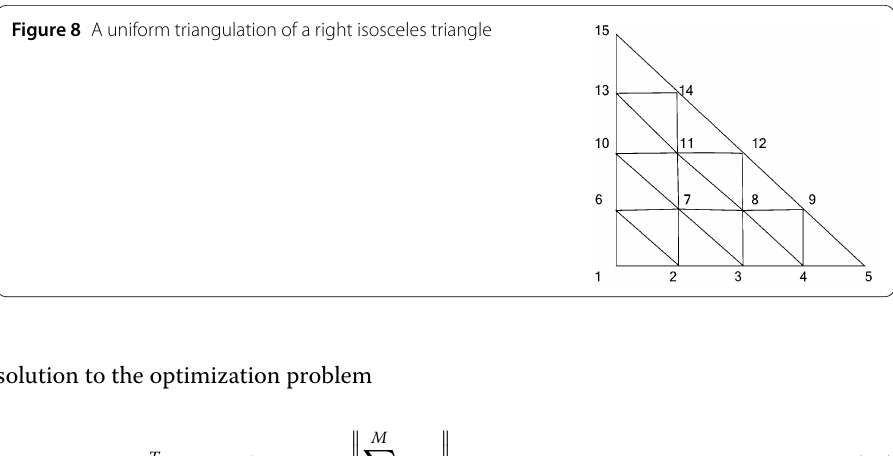
Figure 8 A uniform triangulation of a right isosceles